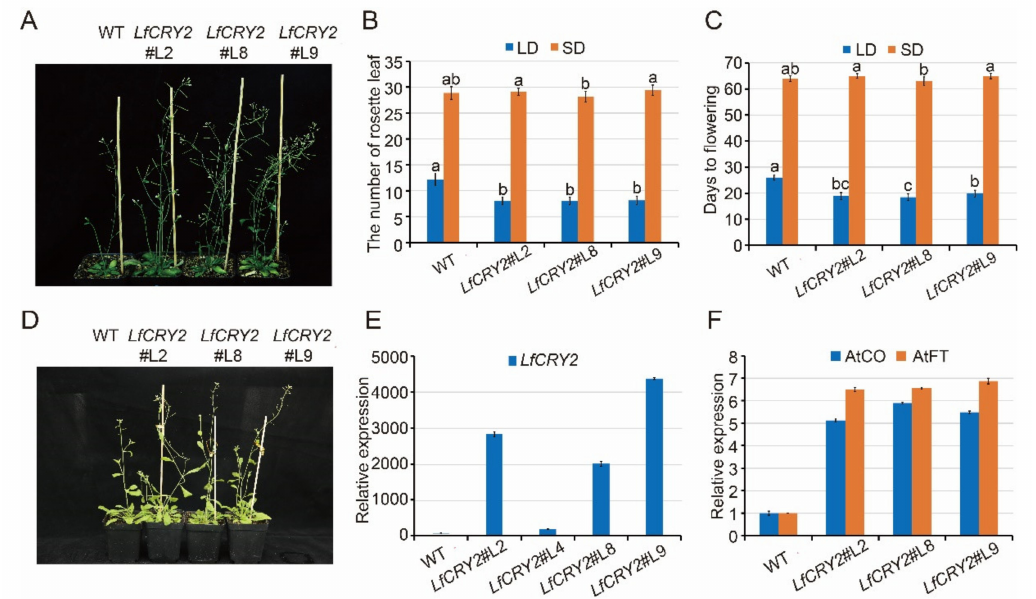
Figure 4. Overexpression of LfCRY2 promotes flowering in Arabidopsis . ( A , D ) Flowering traits of WT Arabidopsis and transgenic 35S::LfCRY2 lines under LDs and SDs. ( B , C ) The flowering time and rosette leaf number of WT Arabidopsis and transgenic 35S::LfCRY2 lines under different photoperiod. ( E , F ) Expression levels of LfCRY2 , AtCO , and AtFT in WT Arabidopsis and transgenic 35S::LfCRY2 lines. Error bars represent the SD of three biological replicates.